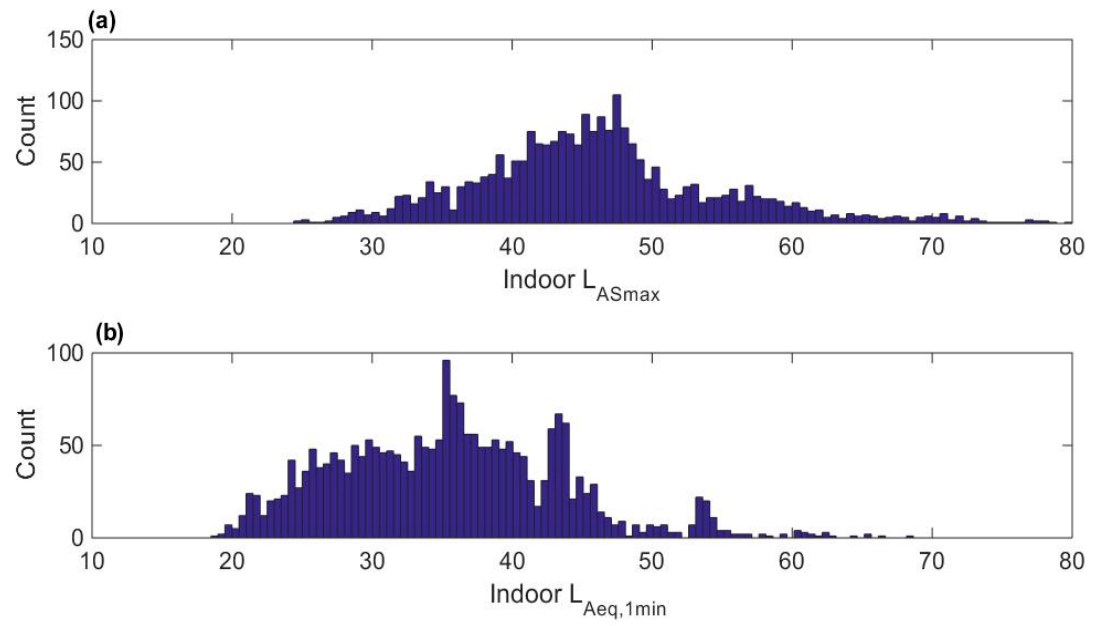
Figure 4. Indoor noise levels for participants near the airport. ( a ) L ASmax of aircraft events; ( b ) L Aeq 1 min before each aircraft event.